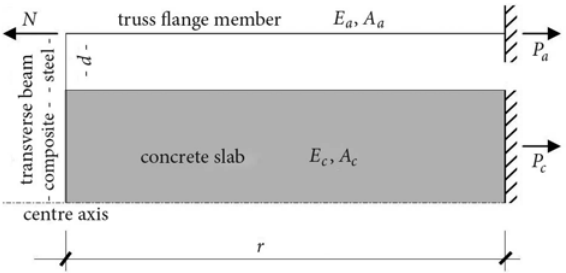
Fig. 5. General scheme of analysis of the truss flange member adjacent to deck